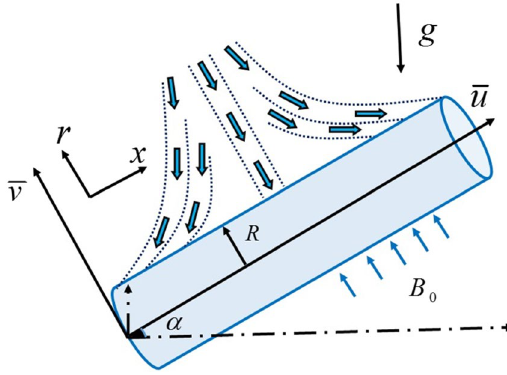
Figure 1. Problem schematic